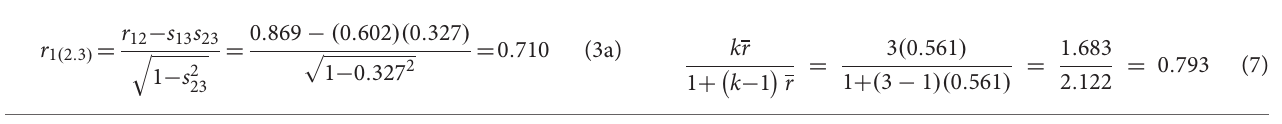
TABLE 2 | Correlation matrix before and after partialing out the conceptual overlap between items. Item from performance approach goal subscale Item